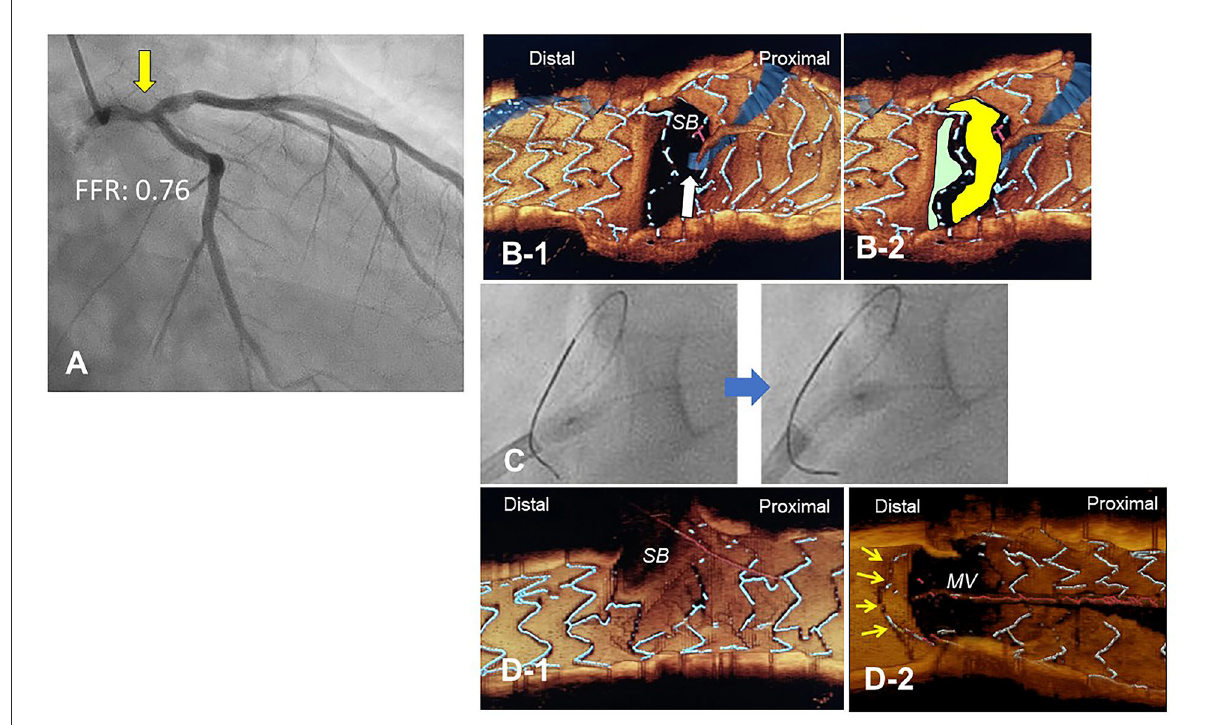
FIGURE10 Push-fold method for complete removal of jailing struts in the side branch (SB) ostium. A 78-year-old man with Medina 1-1-0 lesion in LM bifurcation with a drop of fractional flow reserve (FFR) of 0.76 (A) . After cross-over stenting from LM to LAD with a Xience Alpine 3.5/28mm stent and subsequent proximal optimization in LM with a 4.5mm balloon, guidewire recrossing to the distal cell (green cell) was difficult even after several attempts and finally crossed to the proximal cell (yellow cell, white arrow) (B) . For the removal of the jailing struts in the SB ostium, an inflated 2.5/4mm balloon was pushed from LM to LCX (C) . Final 3-D OCT demonstrated complete removal of the jailing struts in the SB ostium ( D-1 , pull back from main vessel [MV]), and the jailing strut folded toward the carina ( D-2 , pull back from